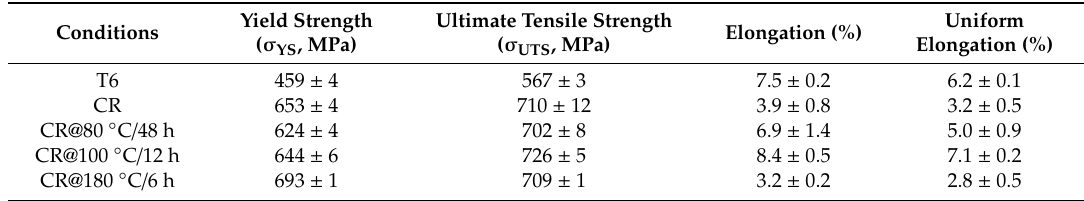
Table 1. Tensile properties of TiB 2 / 2024 composites under di ff erent conditions.